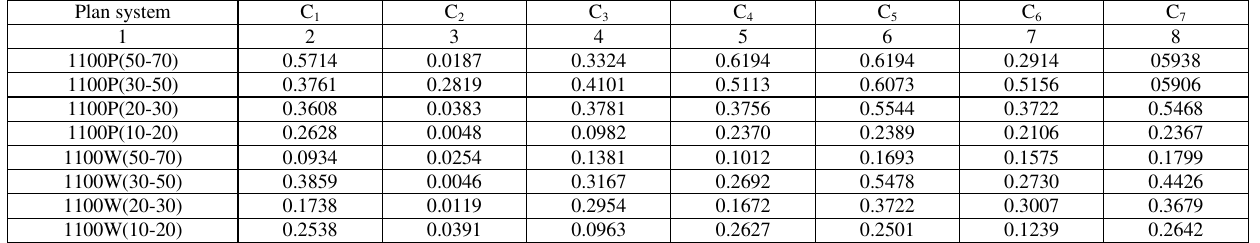
Table 4. Numerical values of the diagnostic variables for λ